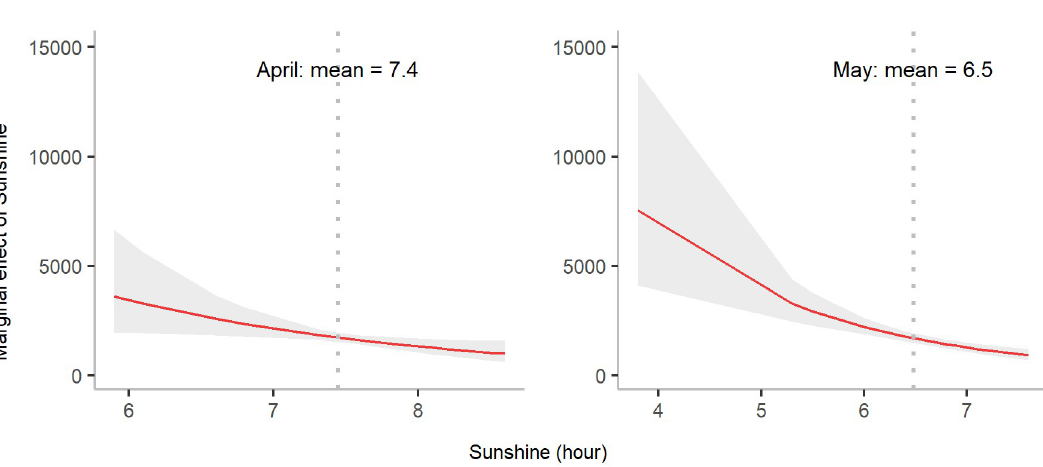
Fig 8. Marginal effect of sunshine duration on annual dengue incidence in April and May. The shaded area denotes the 95% confidence interval of the expected number of annual dengue cases for different values of sunshine duration, whereas the dotted vertical line represents mean sunshine duration for a month. The marginal effect here represents marginal effects at the mean